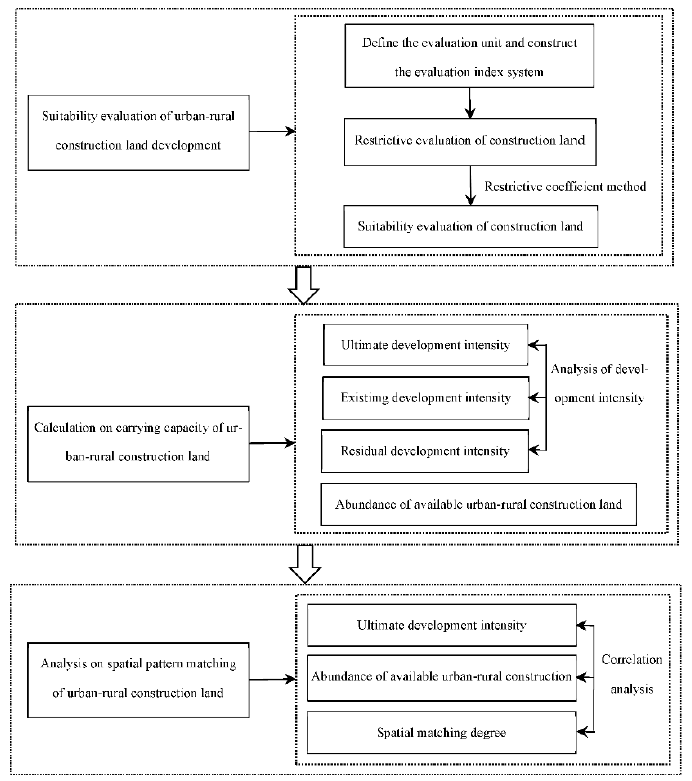
Figure 2. Technical roadmap for the evaluation of carrying capacity and spatial matching pattern of urban–rural construction land.